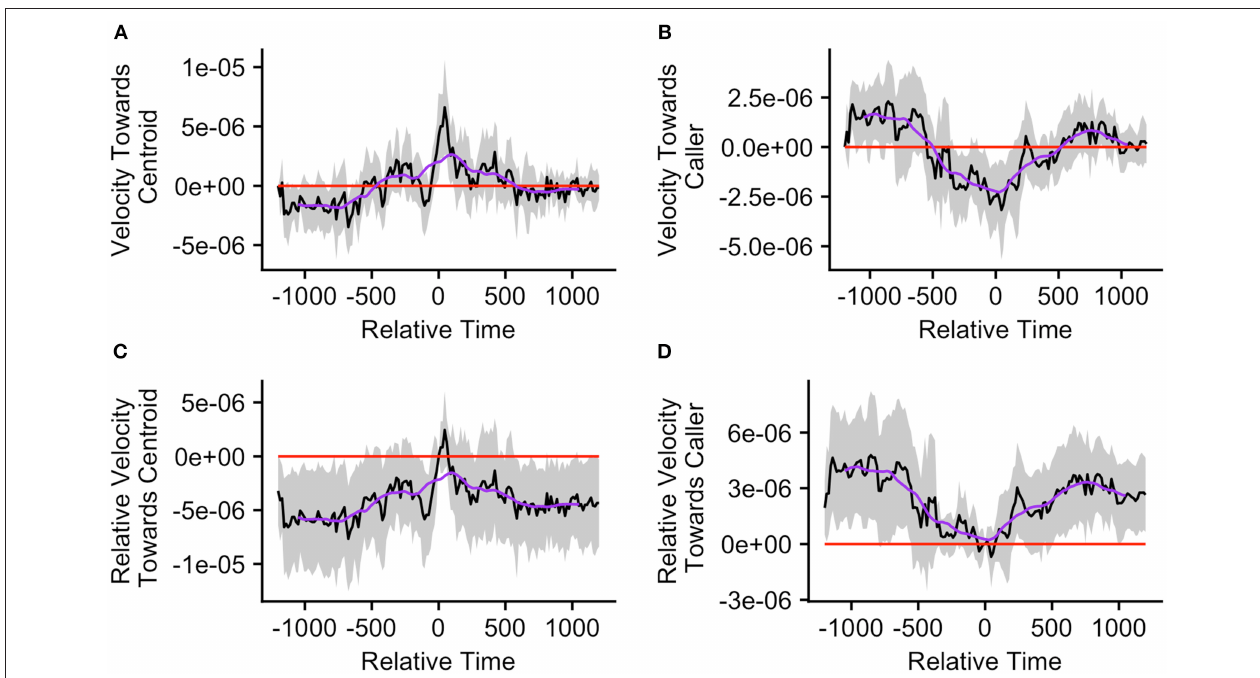
FIGURE 7 | The upper graphs show the mean velocity with 95% confidence interval of the (A) caller toward the group centroid and (B) group centroid toward the caller, from 20min before to 20min after the production of the first call (relative time = 0) in a call bout. Data are presented for bouts assigned to cluster 1 ( n = 15 calling bouts), which correspond with bouts in which callers are far from the centroid at the time of the call. The lower graphs show the mean difference in velocity (with 95% confidence interval) of the (C) caller toward the group centroid and (D) group centroid toward the caller compared to their own velocities at the time of the call (relative time = 0). The purple line represents the simple moving average of each plotted velocity calculated with a window of 301s centered on each